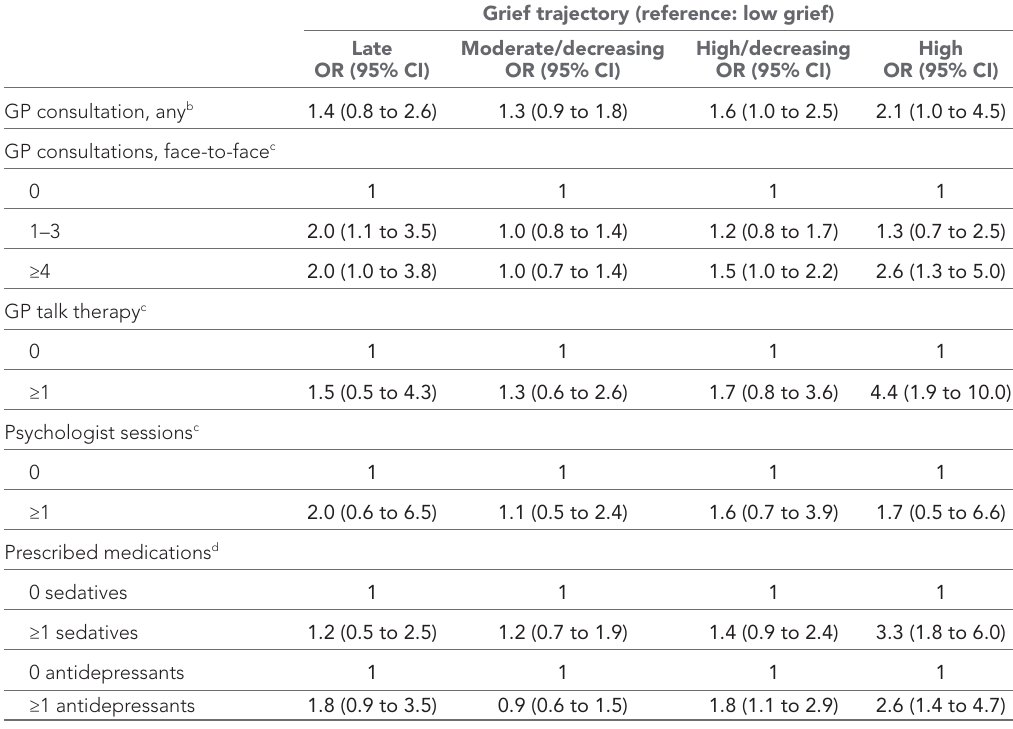
Table 3 Consultations and prescriptions during 6 months before inclusion and associations a with grief trajectories, N =